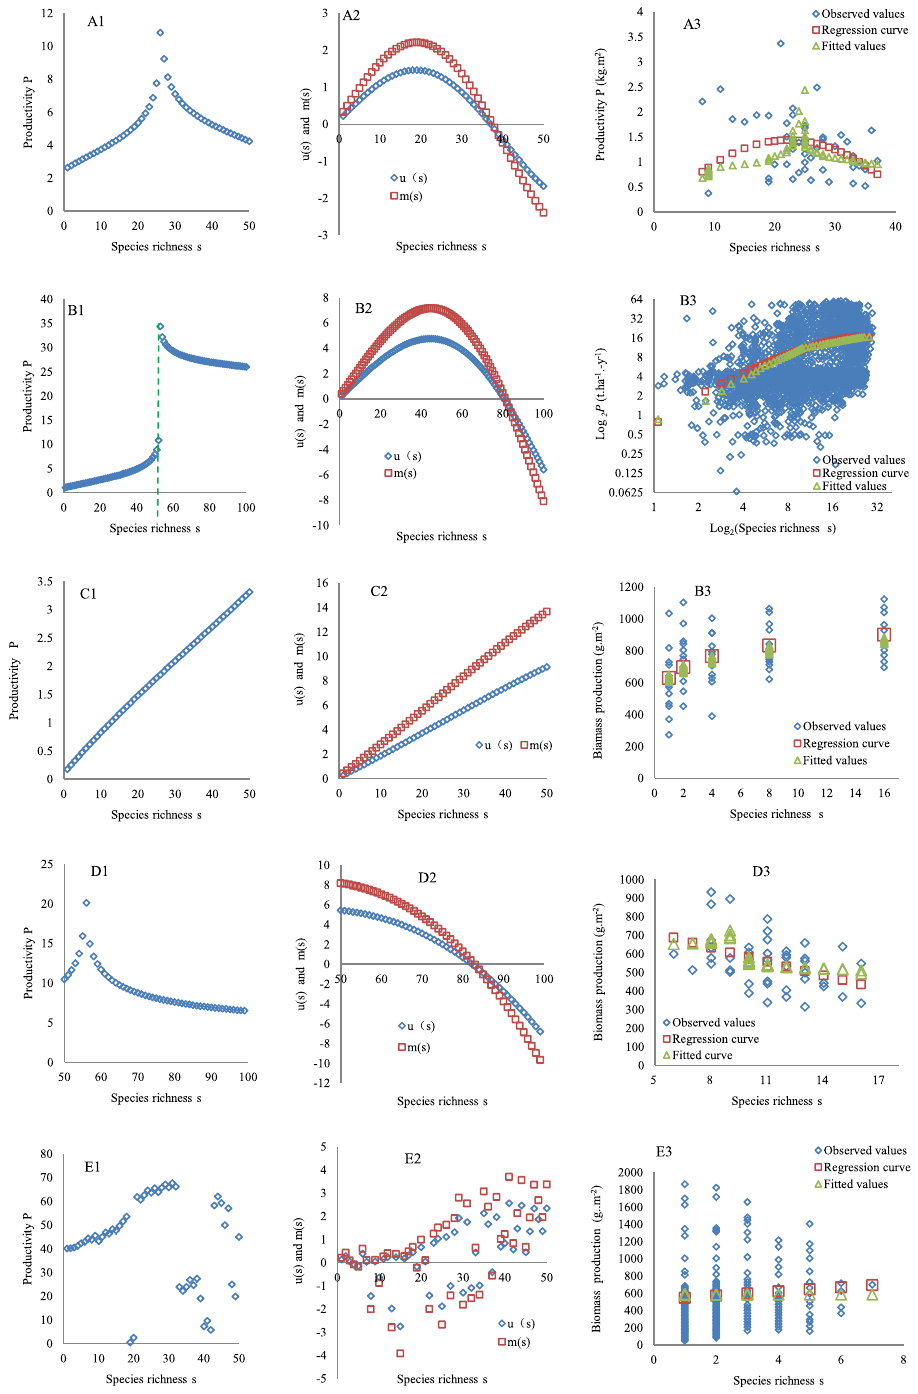
The local derivation in Fig. 1 indicates that the five forms of the PSRR might arise in a plant community with different strengths of ecological processes. Thus, the five PSRR forms were used as the initial forms in deciduous coniferous forests (DCF) to determine the changes in the